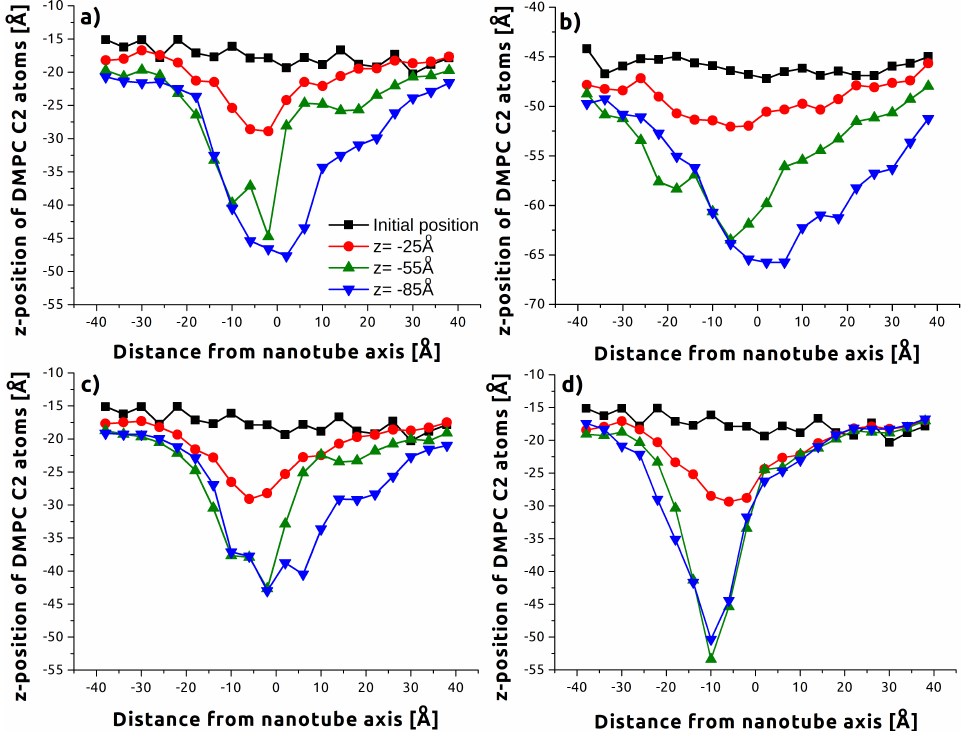
Figure 5. Sequential profiles of average DPMC backbone C2 atom position for CNT systems angled at 15 ◦ to a resolution of 4 Å. Z -values correspond to the stages shown in Figure 1. Each plot represents a different case: ( a ) z -axis indentation at 2 m/s—upper layer, ( b ) z -axis indentation at 2 m/s—lower layer, ( c ) z -axis indentation at 0.5 m/s—upper layer, ( d ) tube-axis indentation at 2 m/s—upper